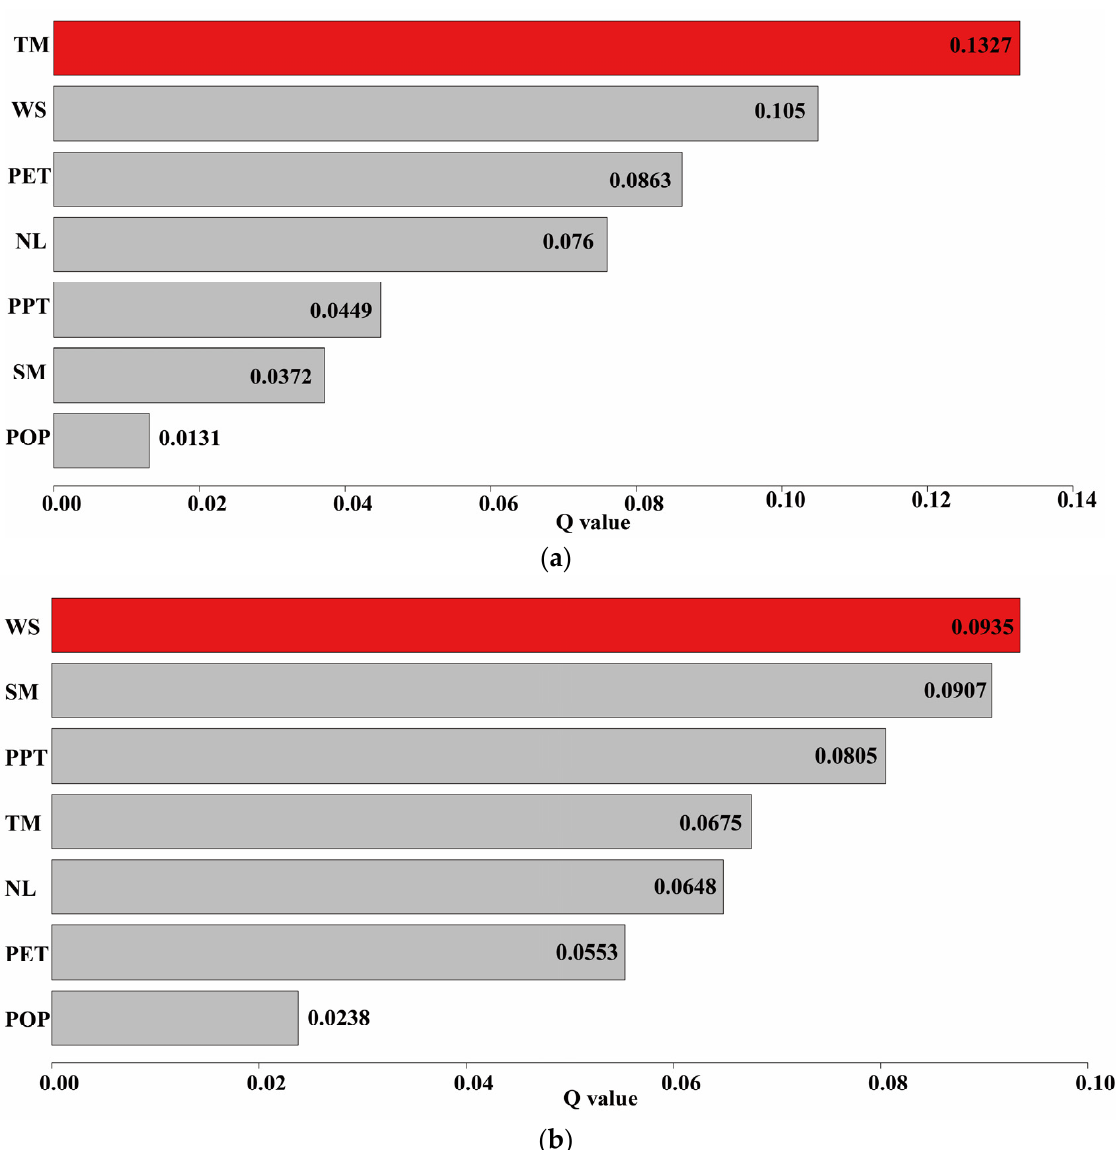
Figure 10. PD value of desertification drivers. ( a ) East Ujimqin Banner; ( b ) the three counties in